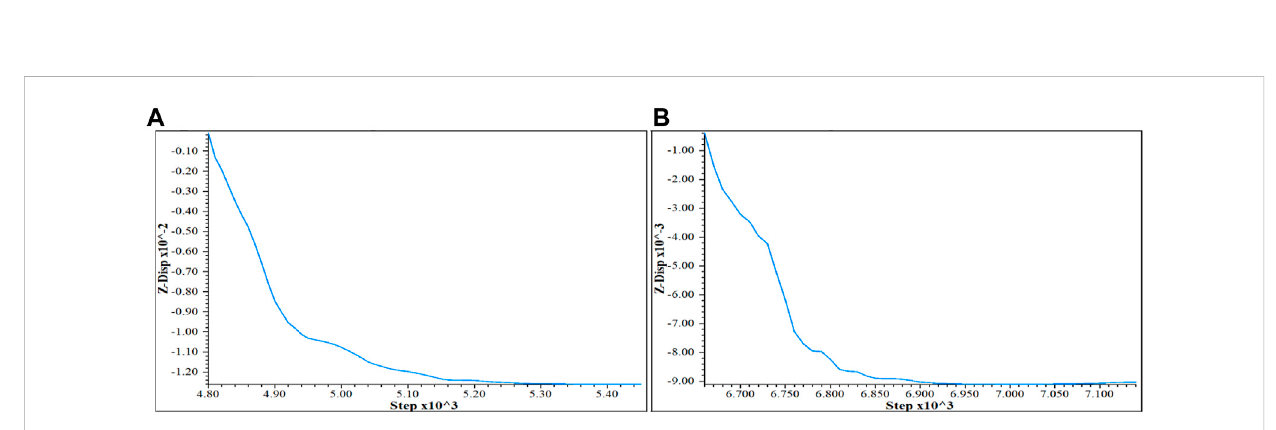
FIGURE 12 Vertical displacement curve when the internal friction angle changes. (A) Vertical displacement curve when the internal friction angle is 20 ° (with support). (B) Vertical displacement curve when the internal friction angle is 40 ° (with